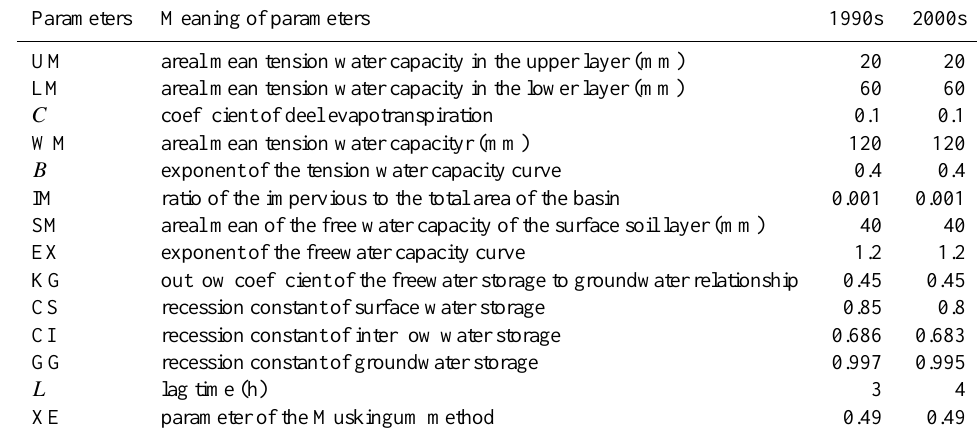
Table 4. Calibrated parameters for the hourly Xinanjiang model in Dapoling sub-basin.